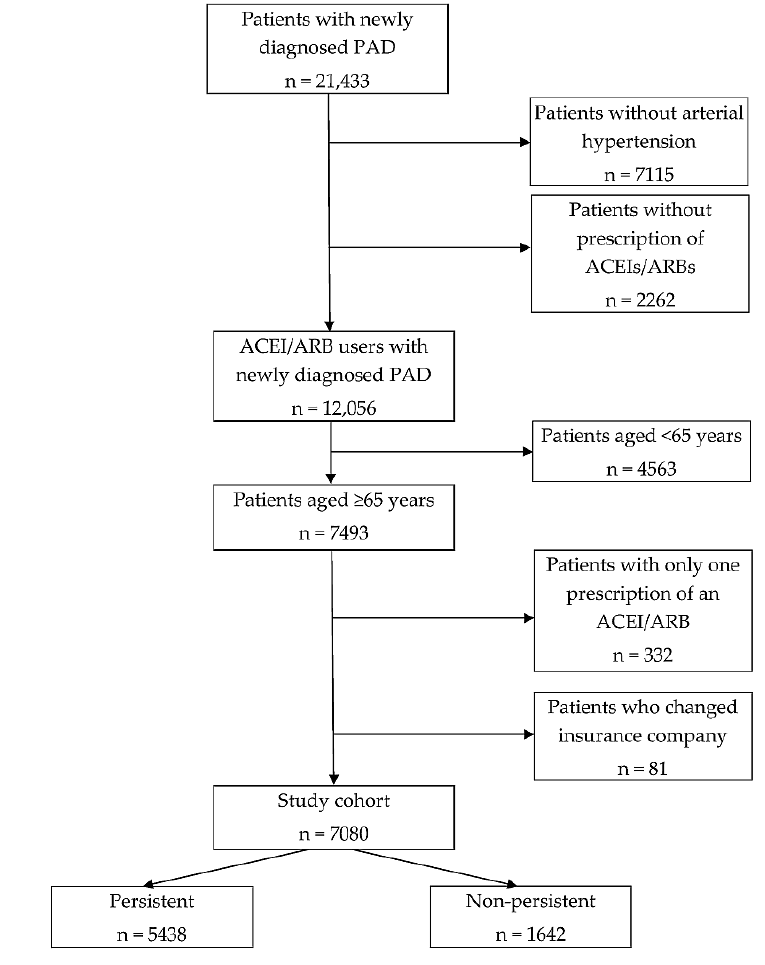
Figure 1. Flow chart showing derivation of the study cohort (n = 7080).